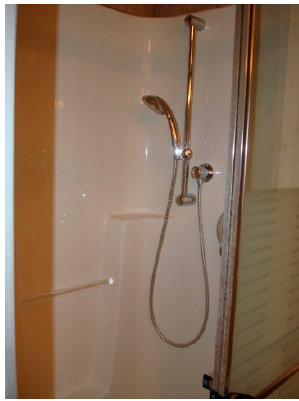
Figure 3. Independence through a walk-in shower.